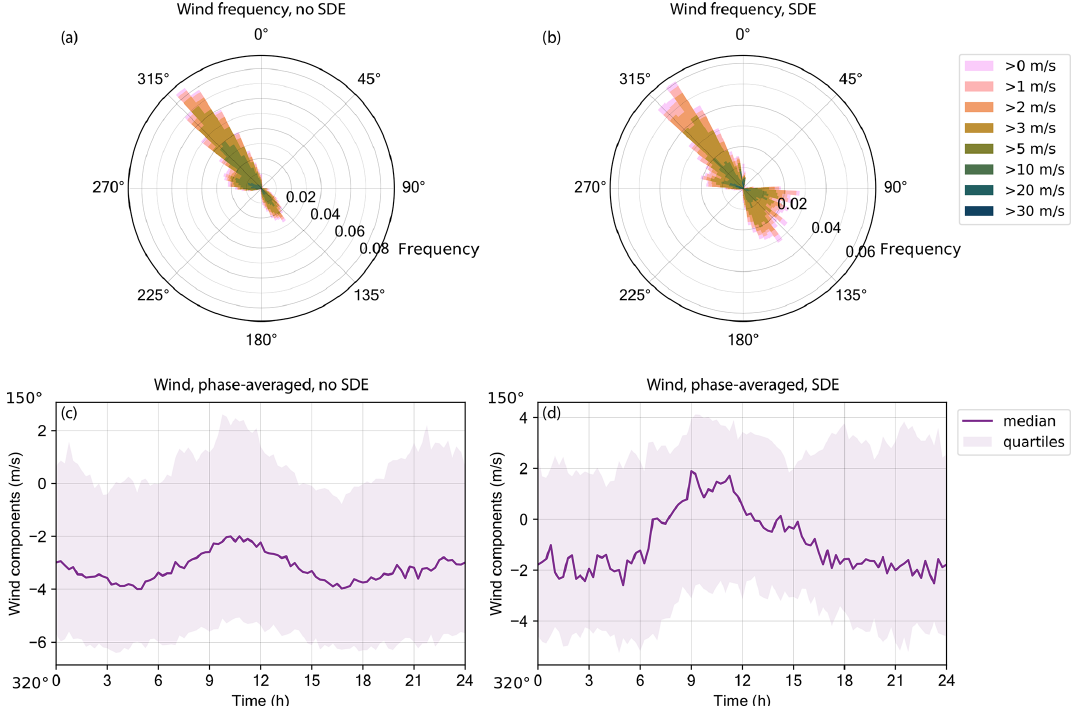
Figure A1. Observed wind frequency for each direction and wind velocity at JFJ between 7 February and 31 December 2020 for non-SDE periods ( a ) and for SDE periods ( b ). Furthermore, phase-averaged plot of the wind components in the two principal wind directions (150 and 320 ◦ ) for non-SDE periods ( c ) and for SDE periods ( d ). During SDE periods, southeasterly winds were more frequent, leading to median winds from southeasterly directions during 07:30 and 12:30UTC, whereas during non-SDE periods the median wind never came from southeasterly directions. By taking a sample of non-SDE winds in each case 1 week prior to an SDE, the phase average (not shown) is nearly identical to the phase-averaged plot shown here for SDE periods, pointing to a seasonal feature rather than one constrained to SDEs.